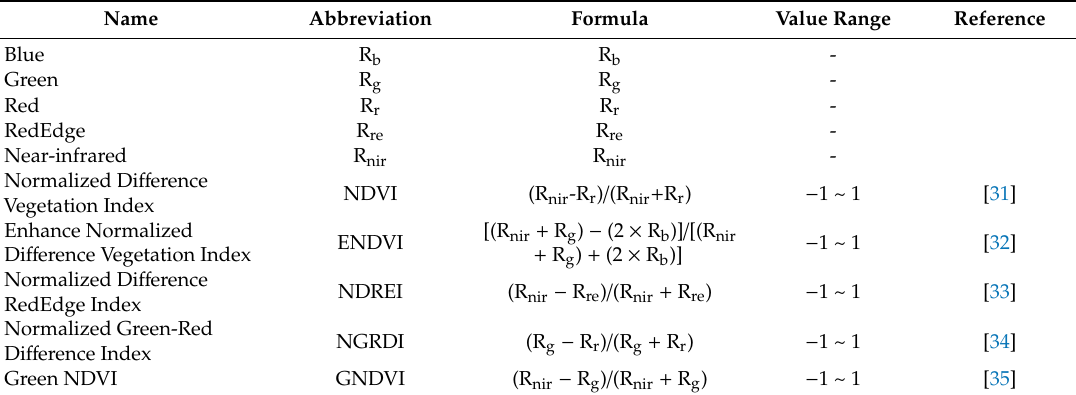
Figure 3. Flight path setting and the UAV operation using Firefly 6 Planner S/W. Table 4. Vegetation indices using multi-spectral